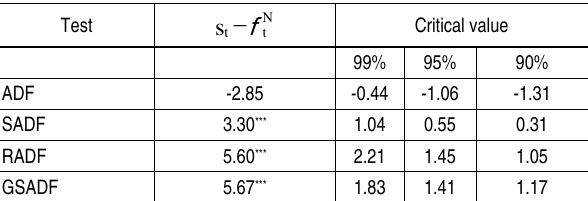
for exchange rate-relative price of nontraded